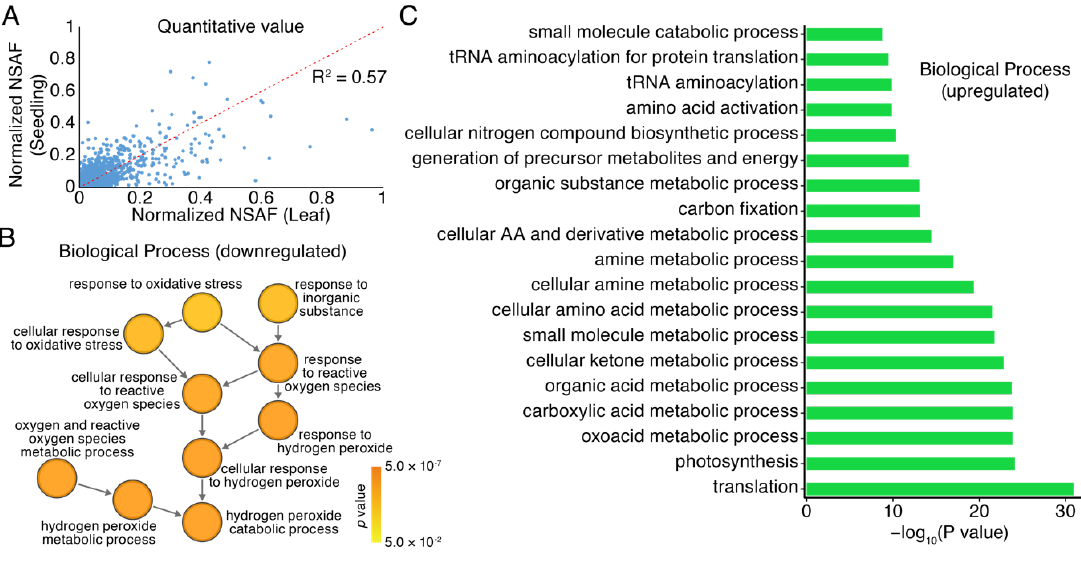
Figure 3. The gene ontology (GO) enrichment analysis of differential expression proteins in seedlings and leaves of moso bamboo based on mass spectrometry-based label-free quantitative proteomics. ( A ) The correlation analysis of protein abundance between seedlings and leaves of moso bamboo; ( B ) The biological process for down-regulated proteins; ( C ) The biological process for up-regulated proteins.